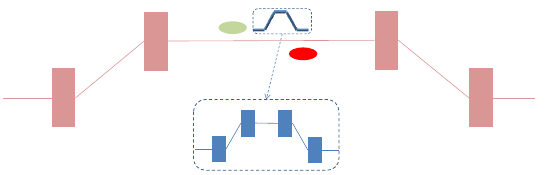
FIG. 2. A schematic layout of the electron delay system (not to scale). The small chicane in the blue dashed square is inserted into the large chicane. The inserted chicane here is used to delay the low-energy bunch.